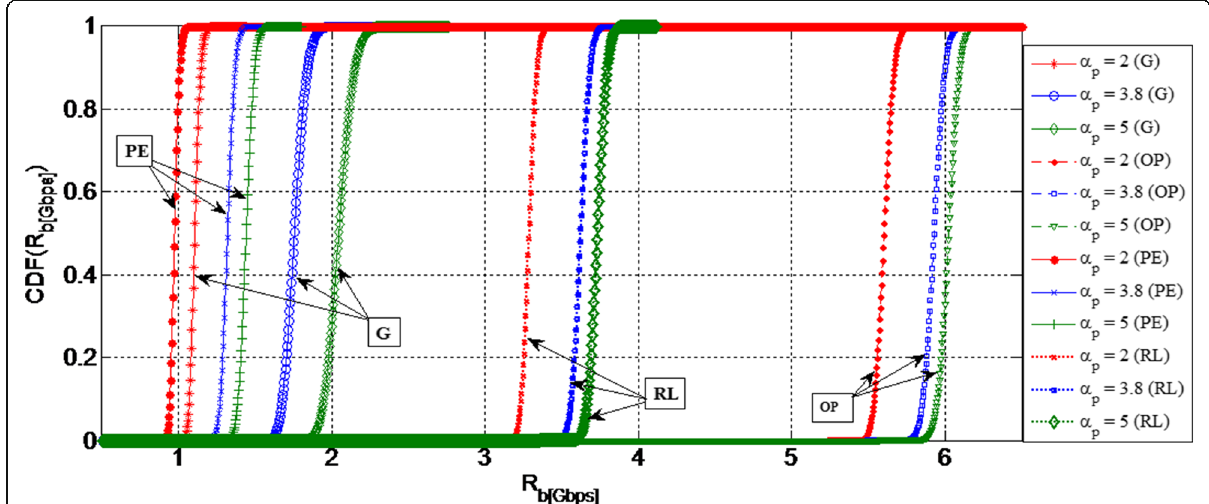
Fig. 2 CDF of cellular networks data rate for different